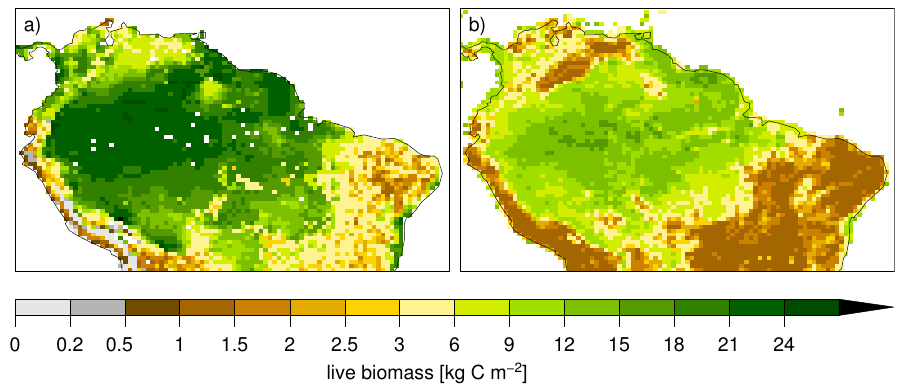
Fig. 3. Simulated aboveground C-storage in living biomass (a) after corrections to maximum establishment rate and maximum crown diam- eter in LPJ compared to aboveground live biomass values derived from Saatchi et al. (2009) (b) .